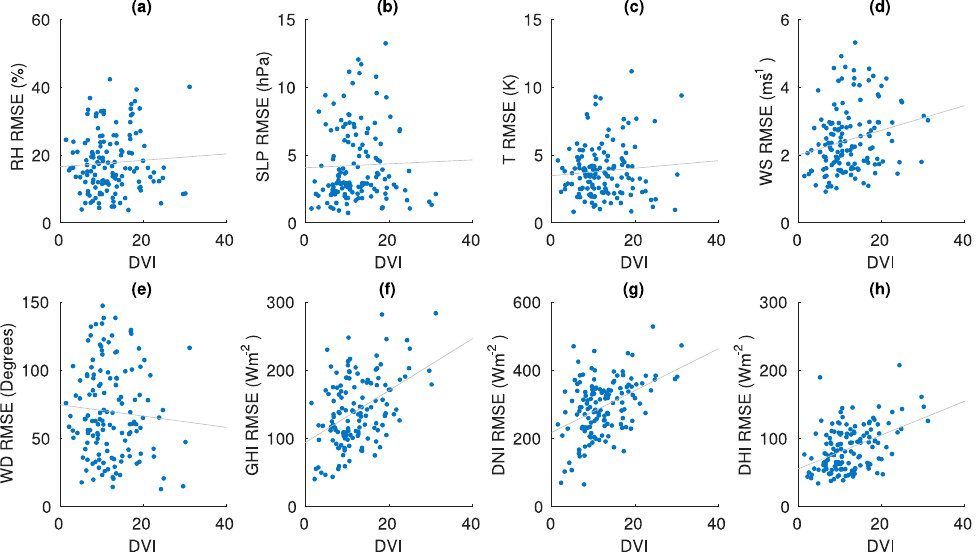
Figure 14. Variation of errors (RMSE) in surface (( a ) RH, ( b ) SLP, ( c ) T, ( d ) WS, and ( e ) WD) and solar irradiance (( f ) GHI, ( g ) DNI, and ( h ) DHI) variables with varying degrees of intermittency (DVI) for WRF-Solar simulations at 45 km grid spacing. The best fit line is also shown in grey.